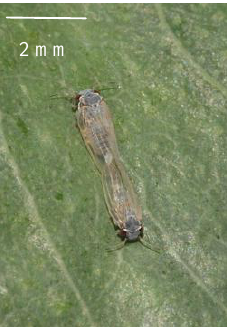
Figure 1. A pair of blue gum psyllids ( Ctenarytaina eucalypti ) in copula ; female at top, male at bottom. Photograph courtesy of Ben